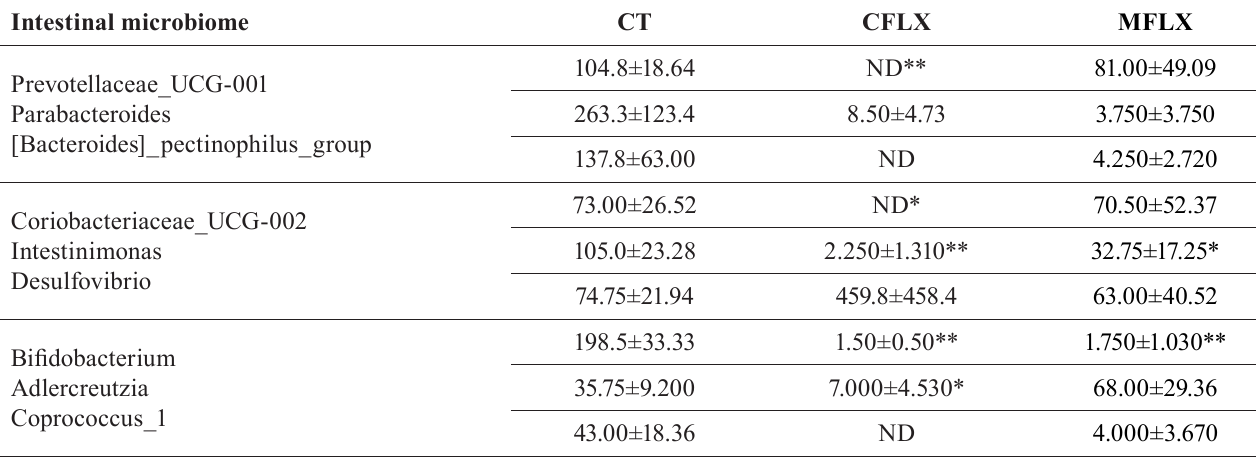
Supplementary Table SIV - The genus abundance of intestinal